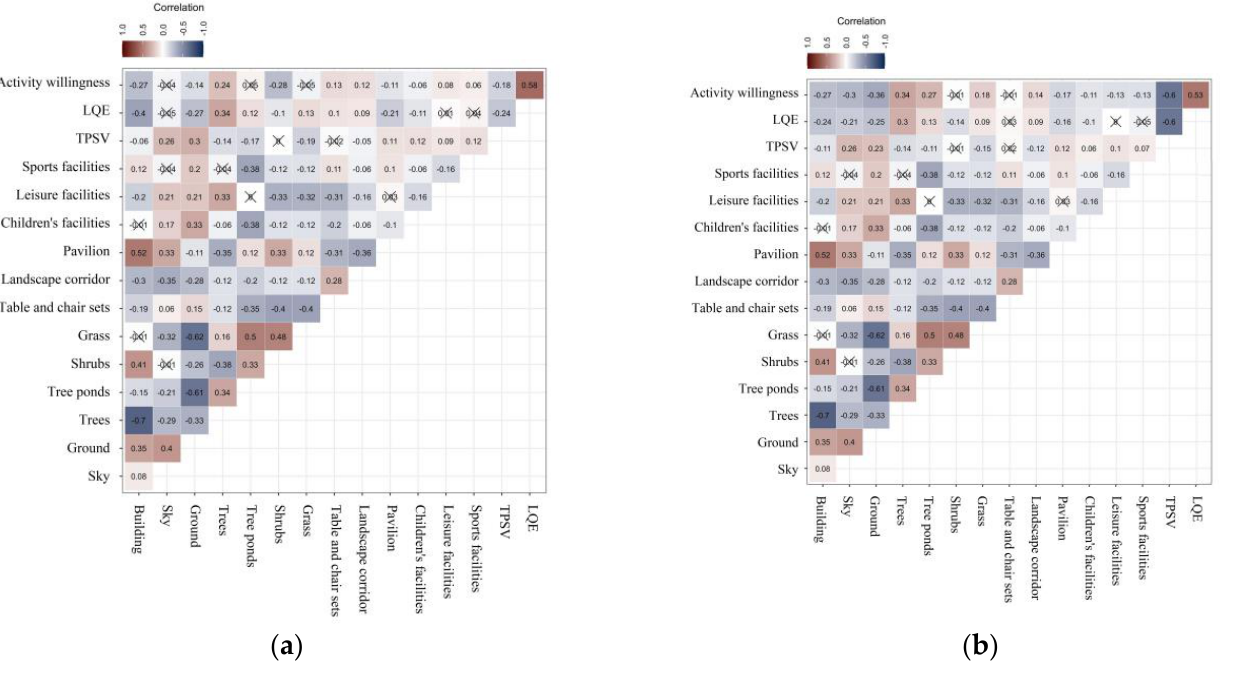
Figure 2. ( a ) Spearman’s rank correlation matrix between the percentage of landscape parameters (%) and TPSV in Group 1; ( b ) Spearman’s rank correlation matrix between the percentage of landscape parameters (%) and TPSV in Group